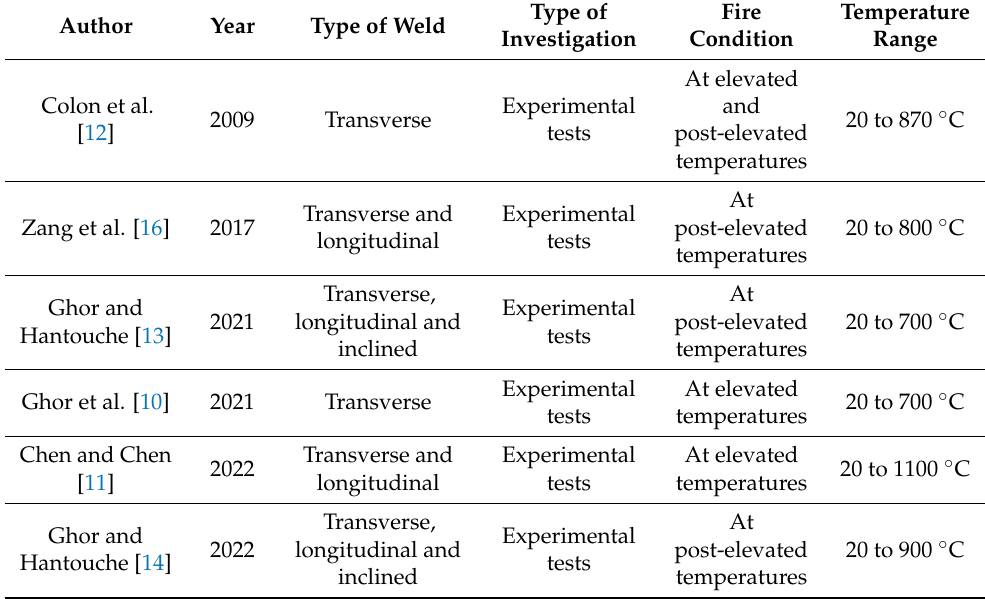
Table 3. Thermal performance of fillet welded joints under static